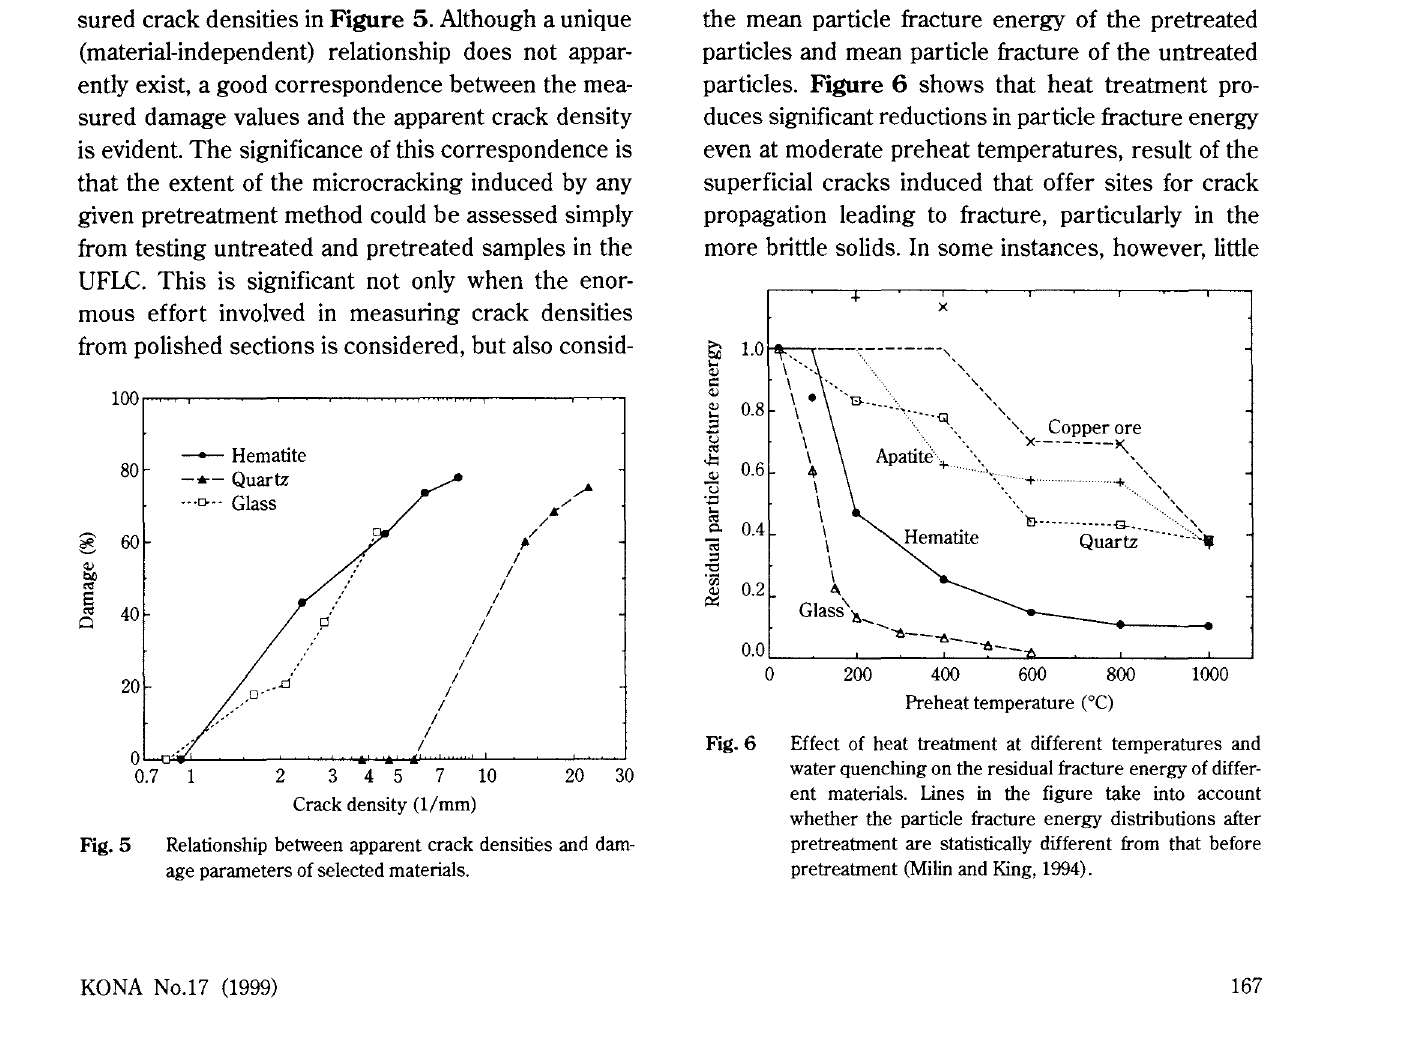
Effect of heat treatment at different temperatures and water quenching on the residual fracture energy of differ ent materials. Lines in the figure take into account whether the particle fracture energy distributions after pretreatment are statistically different from that before pretreatment (Milin and King,